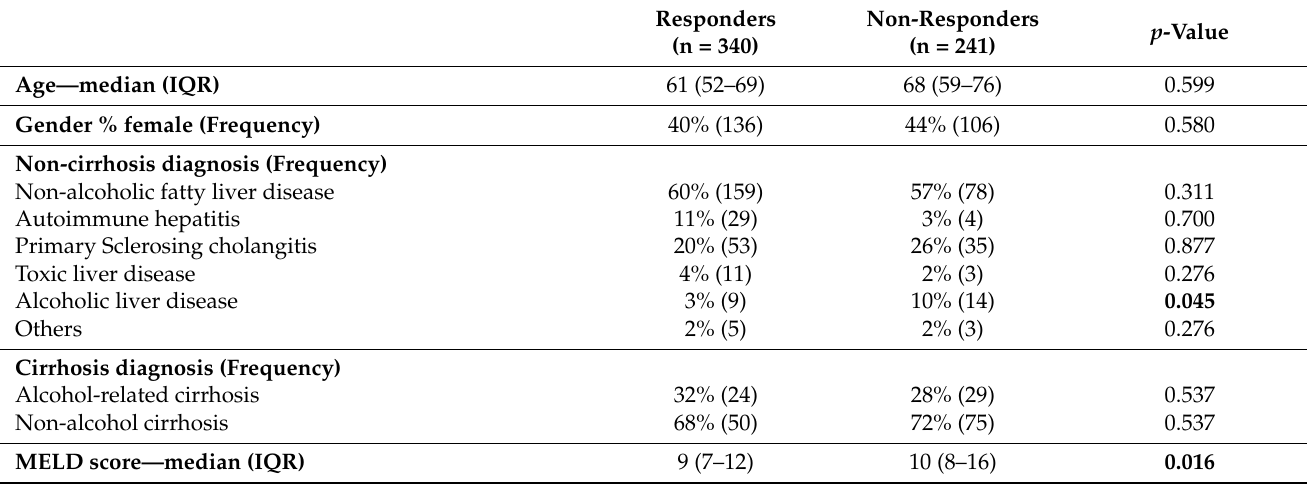
Table 1. Baseline characteristics of responders and